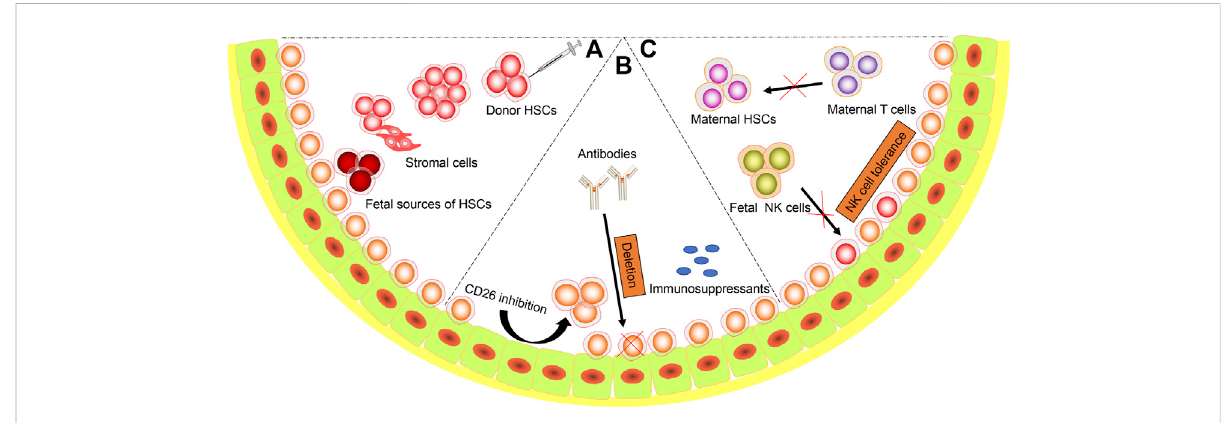
FIGURE 2 StrategiestoSucceedIUHCT.Diagramrepresentingthepossiblestrategiestoovercomethebarriers. (A) Hostcellcompetition.a.Properroutes (intravenous, intraperitoneal, intrahepatic, intracelomic and intracardiac) and time of administration; b. Increasing cell doses. c. Cotransplantation with stromal cells. d. Using fetal sources of stem cells (fetal liver, amniotic fl uid stem cells, etc.); (B) Limited niches. a. Mobilize HSCs from niches. b. Antibodies targeted to host HSCs. c. Maternal immunosuppressants administration; (C) Immune barriers. a. Matched maternal HSCs. b. Induction of host NK cells